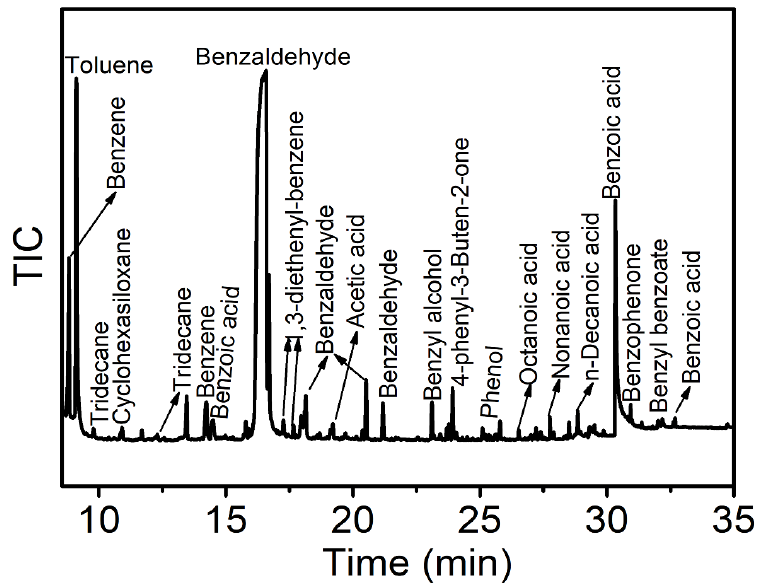
Figure 6. GC-MS spectrum of toluene oxidation o ver α -MO/LMO.